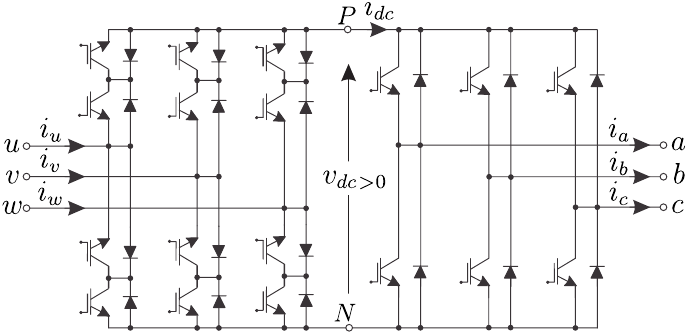
Figure 21. Power stage of an indirect matrix converter.